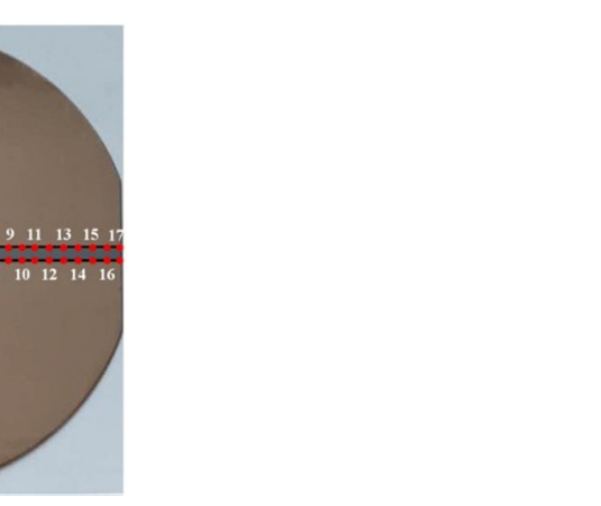
Figure 3. Test points of film thickness on the 2 steps in the deposited Cu film. Yellow dashed line denotes the symmetry axis of substrate.